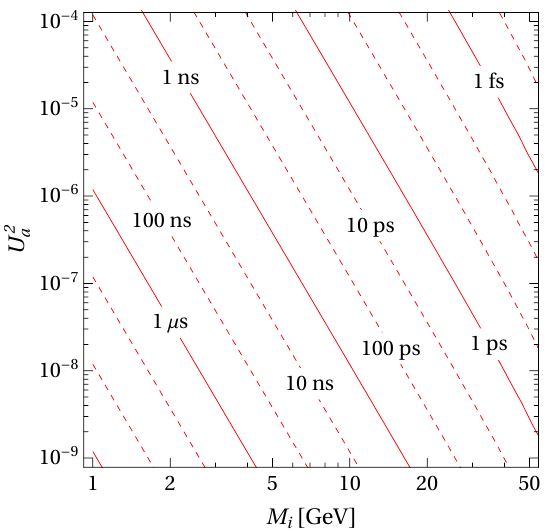
Figure 1. The heavy neutrino life time as a function of its mass and coupling calculated with MadWidth (cf. also relation